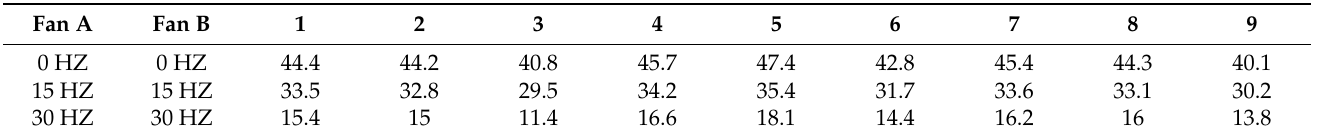
Table 3. Ammonia concentration value in calculation area corresponding to Fan A and Fan B operating frequencies (unit: ppm).